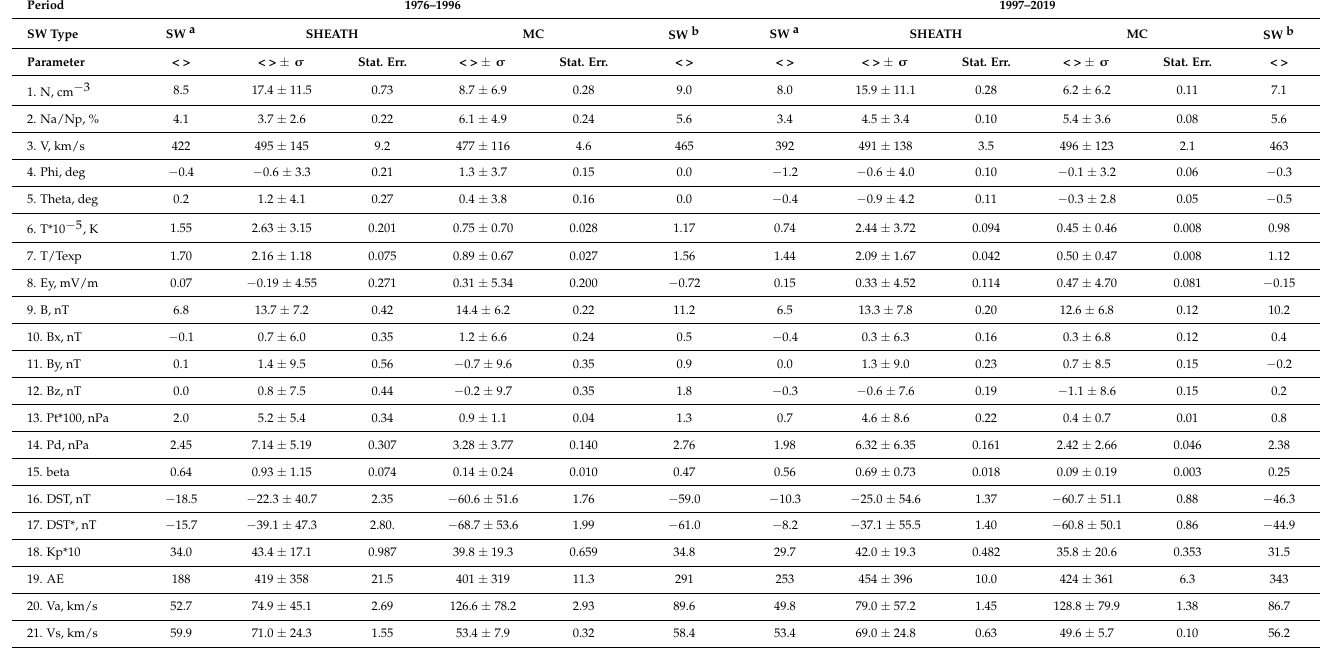
Table 8. Average parameters for sequence SW/IS/SHEATH/MC/SW (Figure